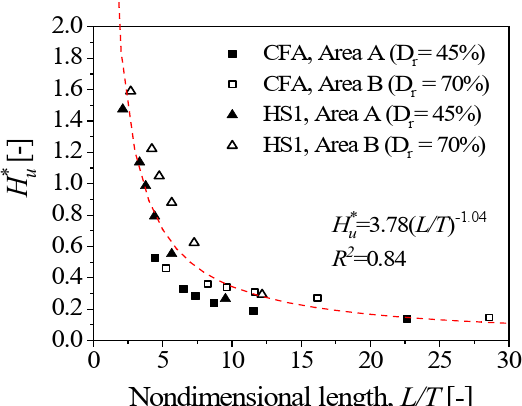
Figure 10. Normalized ultimate lateral capacity of piles H u * as a function of the nondimensional length L/T .